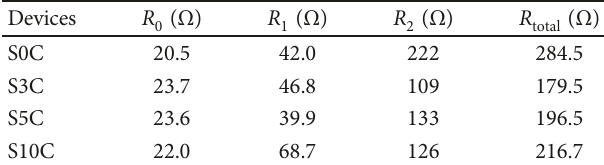
Figure 5: Current versus applied potential curves from DSSCs assembled with S0C, S3C, S5C, and S10C. Table 3: Electrical parameters of the assembled devices. Table 4: EIS parameters from the devices determined by fi tting the data according to the equivalent circuit model (see Figure Devices